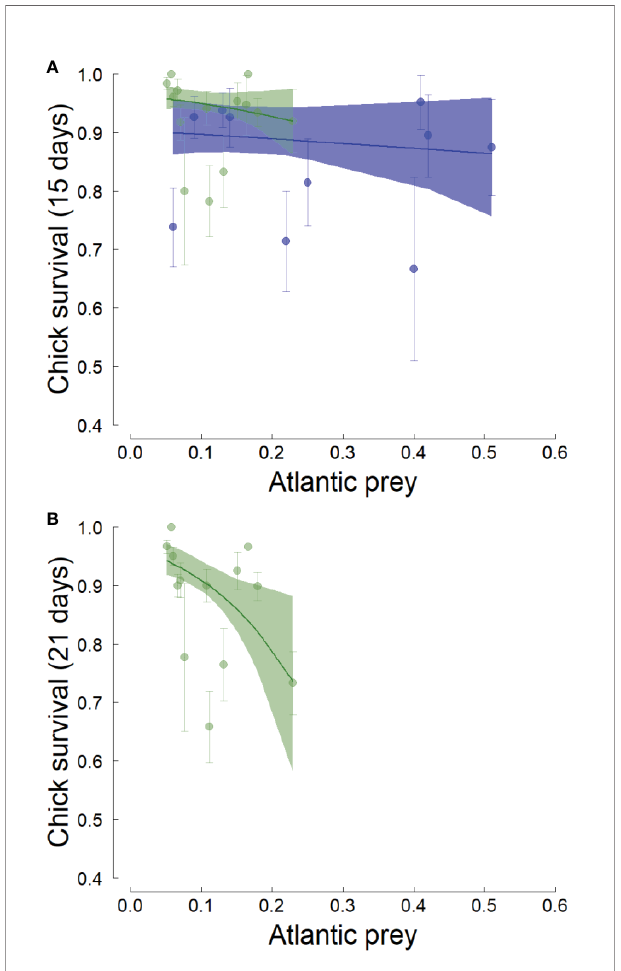
FIGURE 4 | Effect of the average annual proportion of Atlantic prey in the little auk chick diet on chick survival in two western Svalbard fjords (green: Hornsund, blue: Isfjorden). The chick survival was de fi ned as a binary variable describing whether or not the chick has survived until 15 (A) or 21 (B) days of age (data on chick survival until 21 days were not available in Isfjorden). The lines are the regression lines from linear models and the shaded areas represent the bootstrapped 95% con fi dence intervals of the predicted values. Error bars represent the standard errors of the average chick survivals.